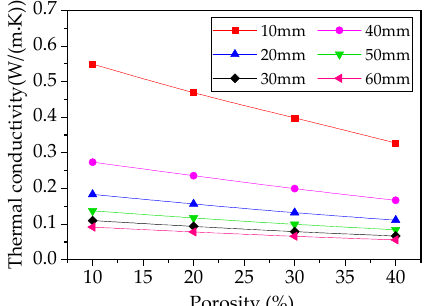
Figure 10. Relationship between porosity and thermal conductivity of samples at different thicknesses.